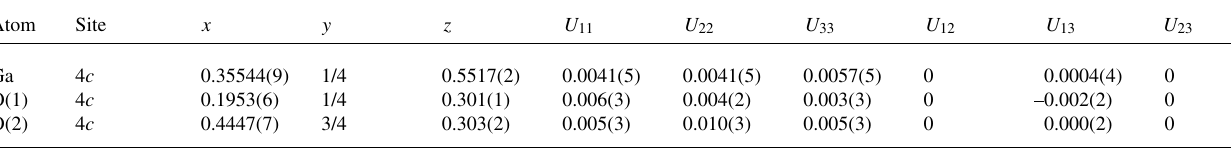
Table 3. Atomic coordinates and displacement parameters (in Å 2 ) .